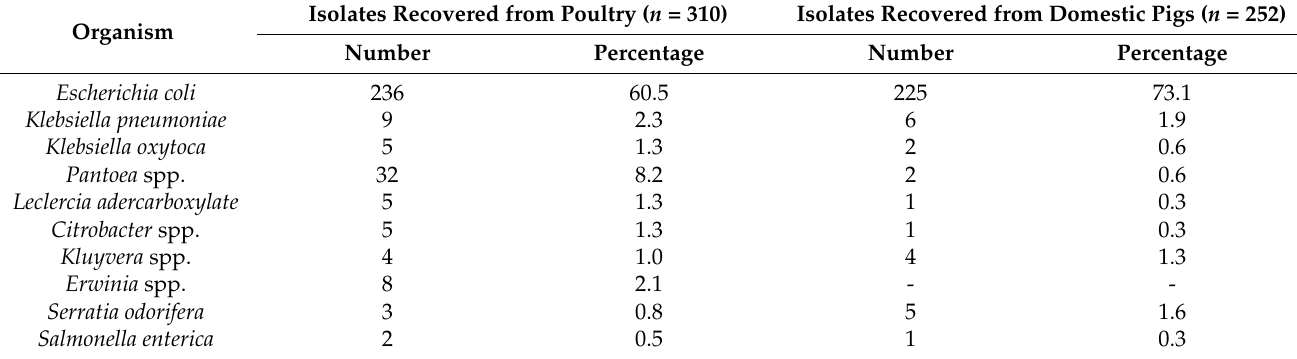
Table 1. Frequency of Enterobacteriaceae isolates from poultry and domestic pigs.